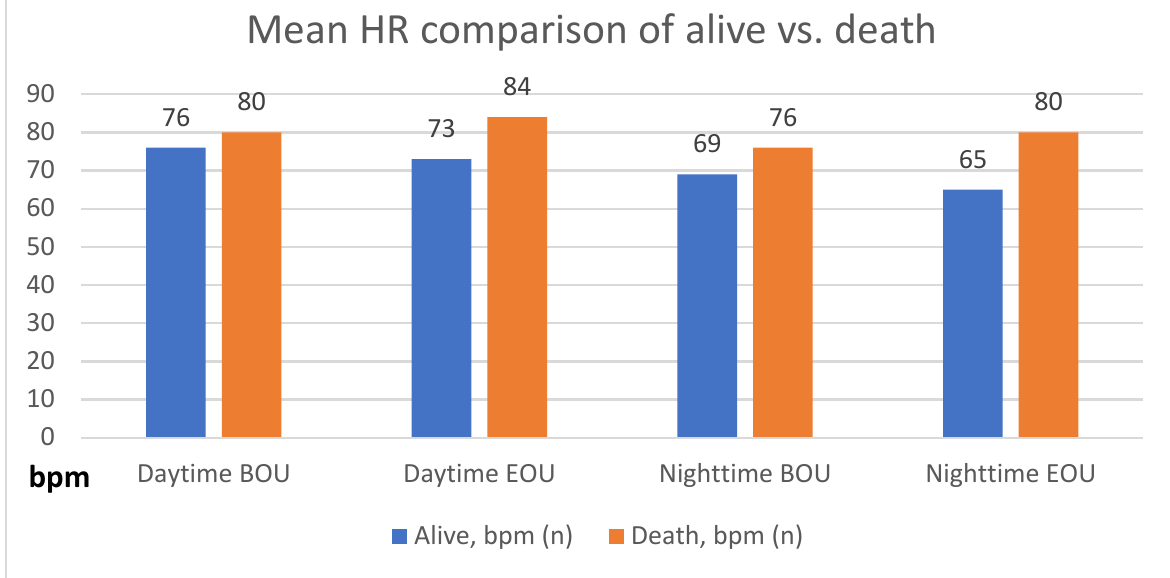
Figure 2. Mean HR comparison of alive vs. dead. Table 2. Mean HR comparison of alive vs. dead.